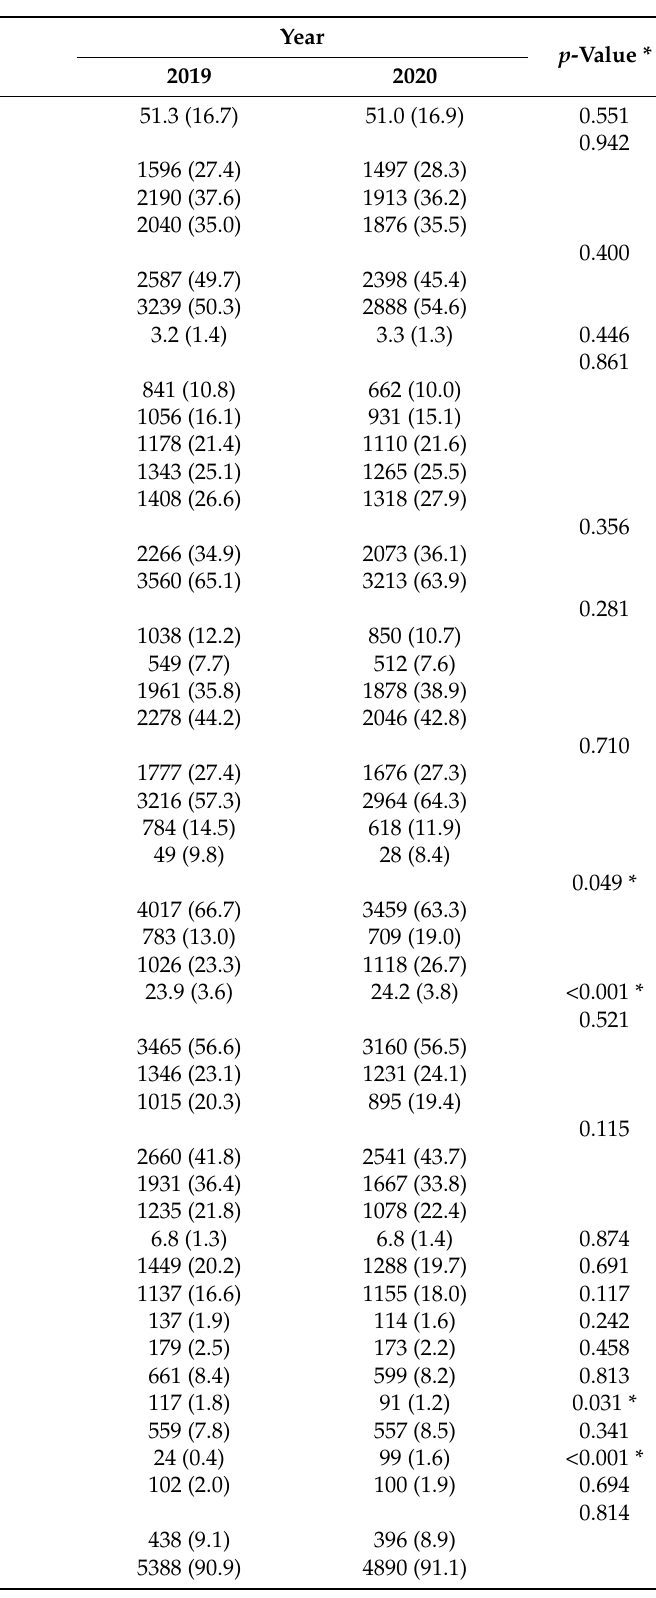
Table 1. General characteristics of